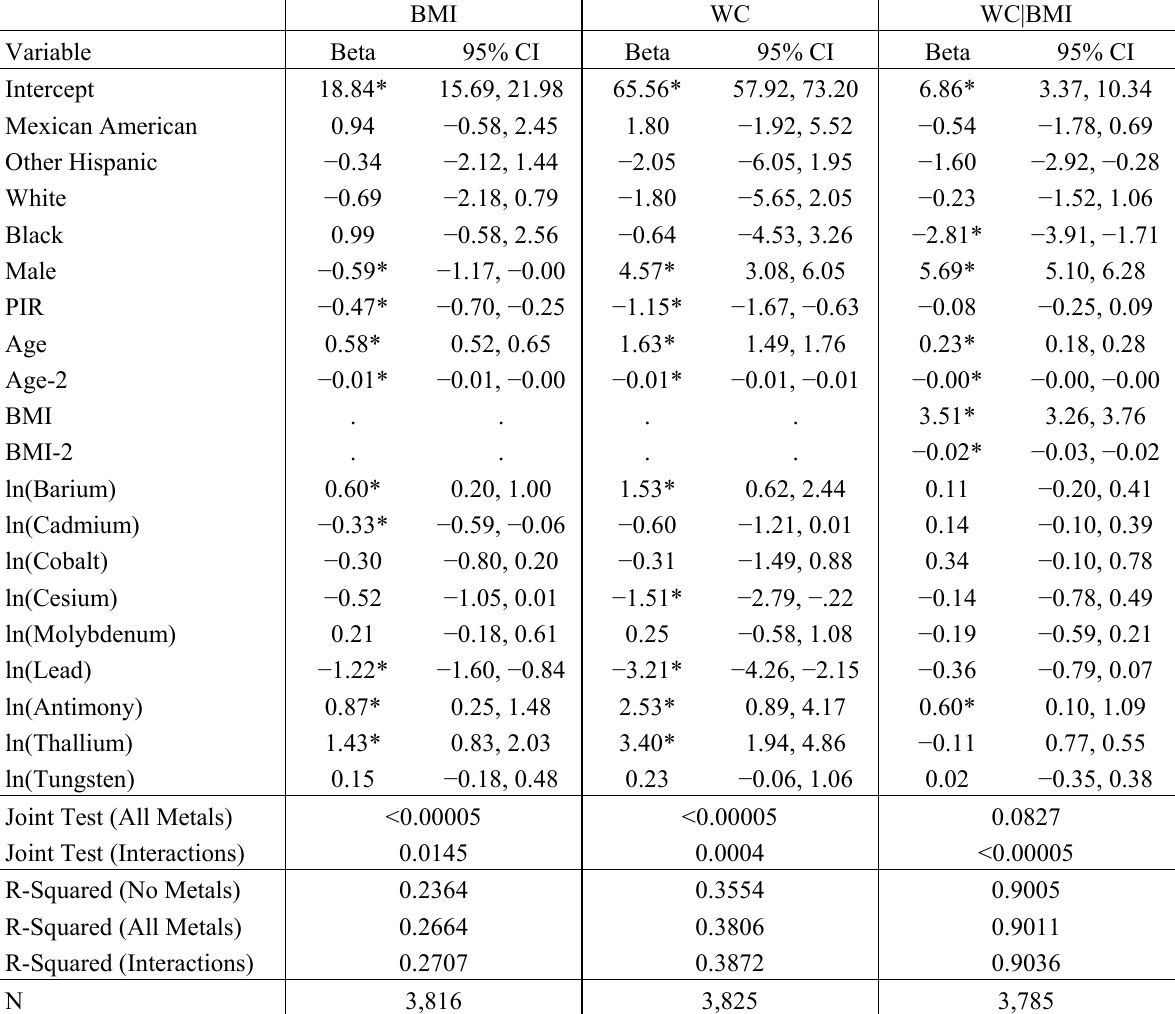
Table 7. Regression Models for All Participants without Creatinine as Covariate.